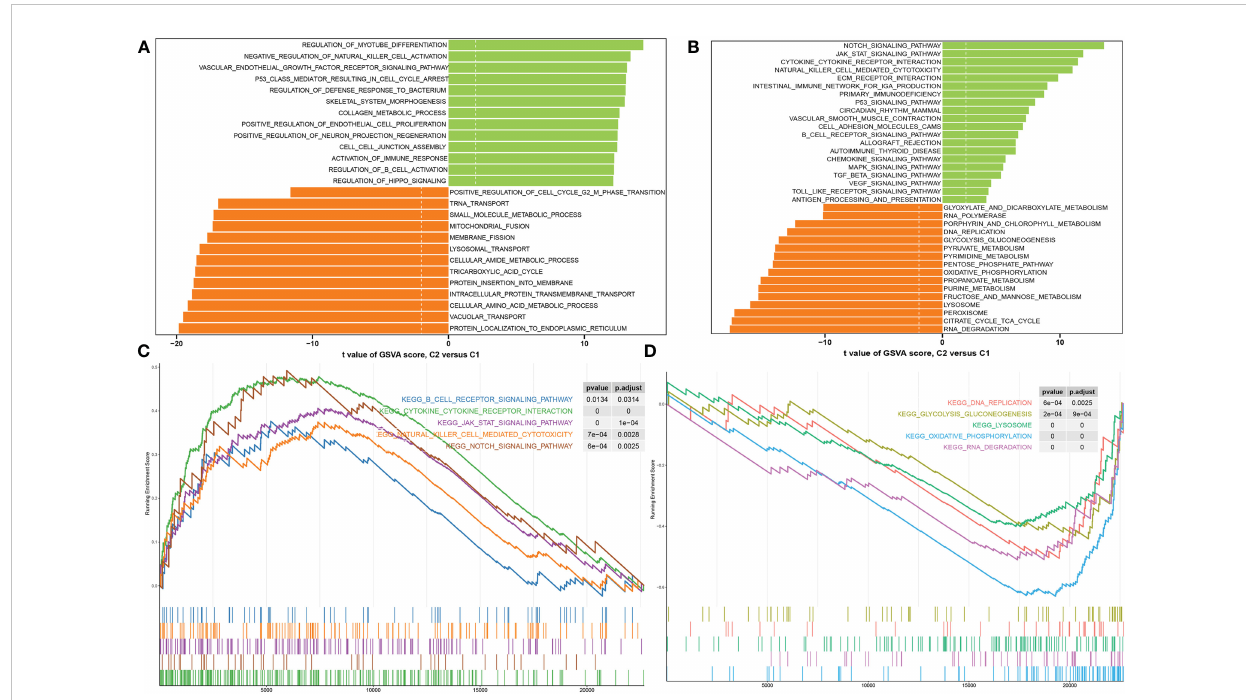
FIGURE 7 Analyses of functional enrichment in DDR subtypes. (A, B) The t-value of the GSVA scores is utilized to rank the differences in abundant biological functions (A) and characteristic signaling pathways (B) between DDR C1 and C2. (C, D) GSEA revealing the elevated (C) and downregulated (D) main pathways in patients with DDR